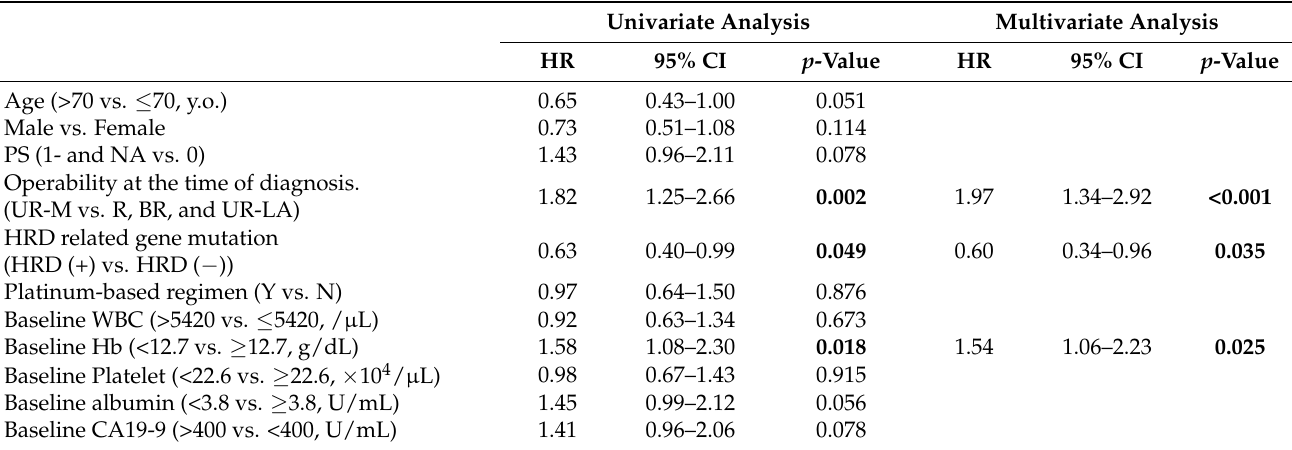
Table 4. Univariate and multivariate analyses of factors associated with overall survival